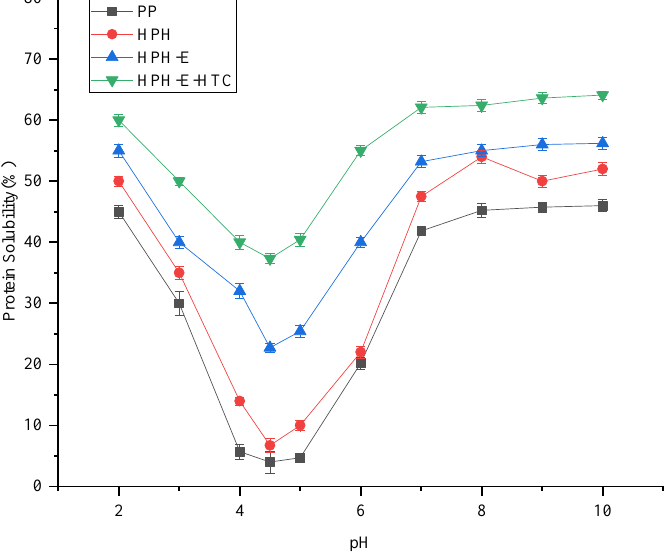
Figure 1. Solubility of peanut protein (PP), high pressure homogenized protein (HPH), high pressure homogenized and enzyme treated protein (HPH-E), and HPH-E-hydrothermally cooked (HPH-E-HTC) protein as a function of pH.